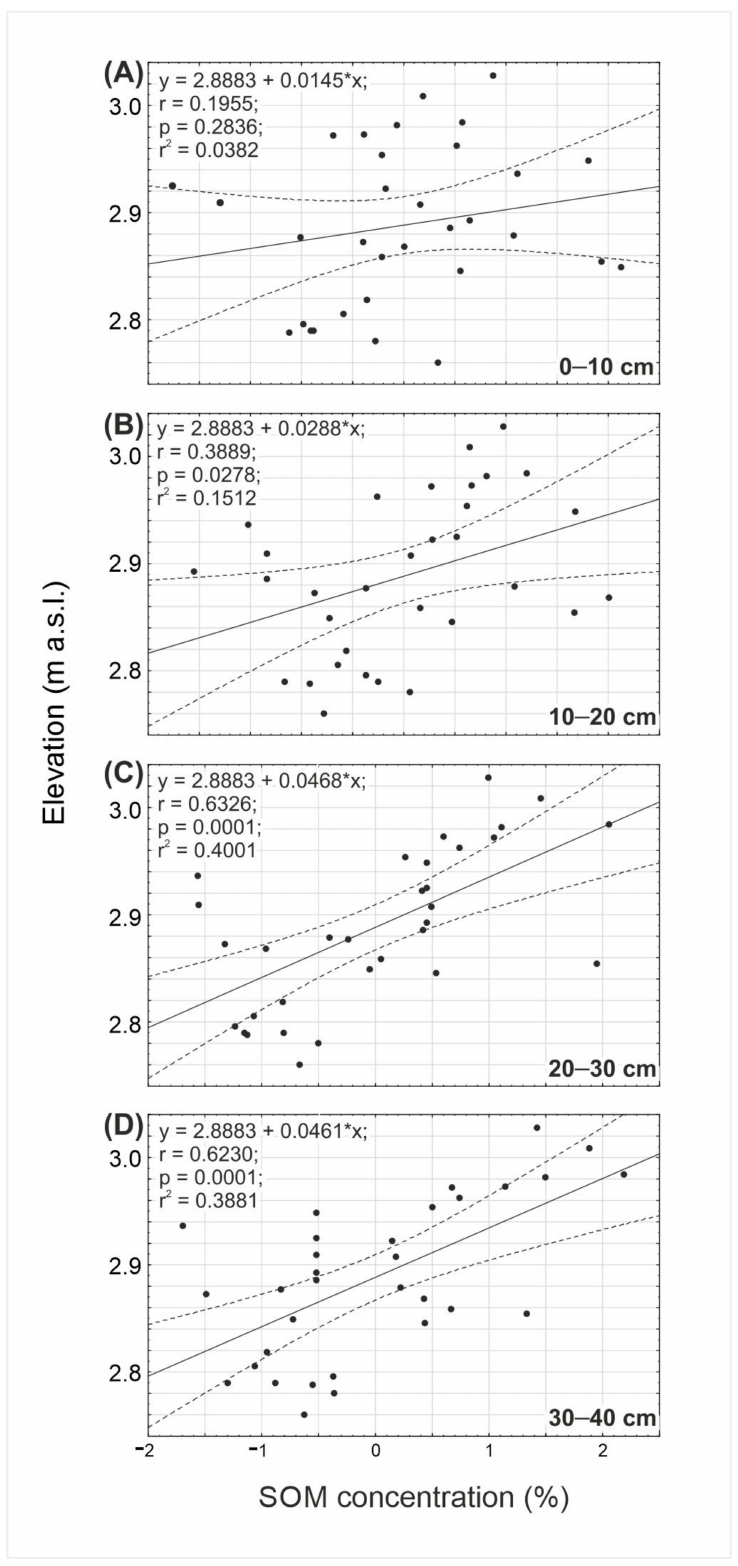
Figure 2. Relationship between soil organic matter concentration and elevation for the studied soil depths (( A ) 0 to 10 cm, ( B ) 10 to 20 cm, ( C ) 20 to 30 cm, ( D ) 30 to 40 cm), assessed using linear models. X-axis and Y-axis present standardized